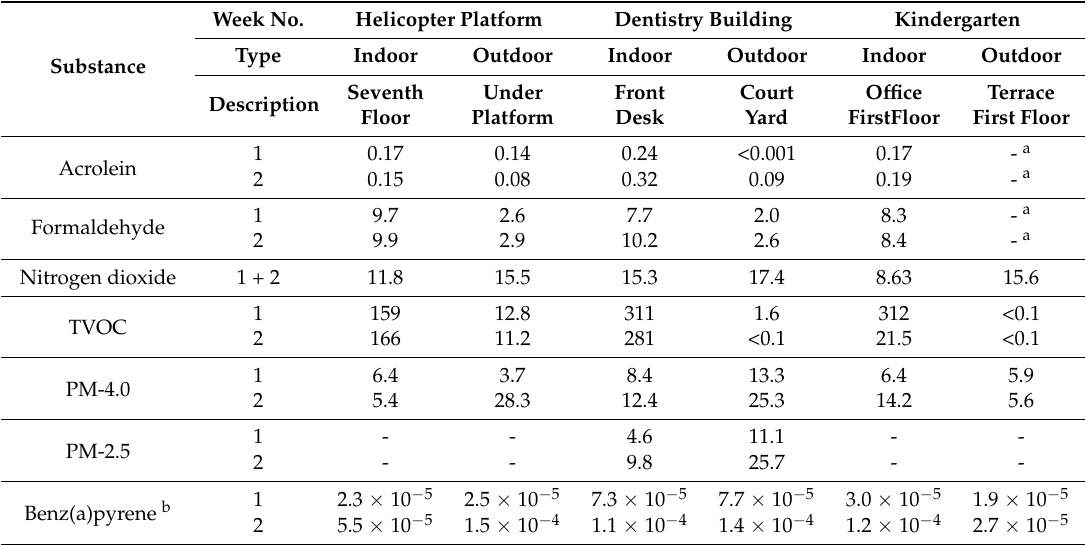
Table 3. Weekly time-weighted average indoor and outdoor concentrations of air pollutants at reference locations ( µ g/m 3